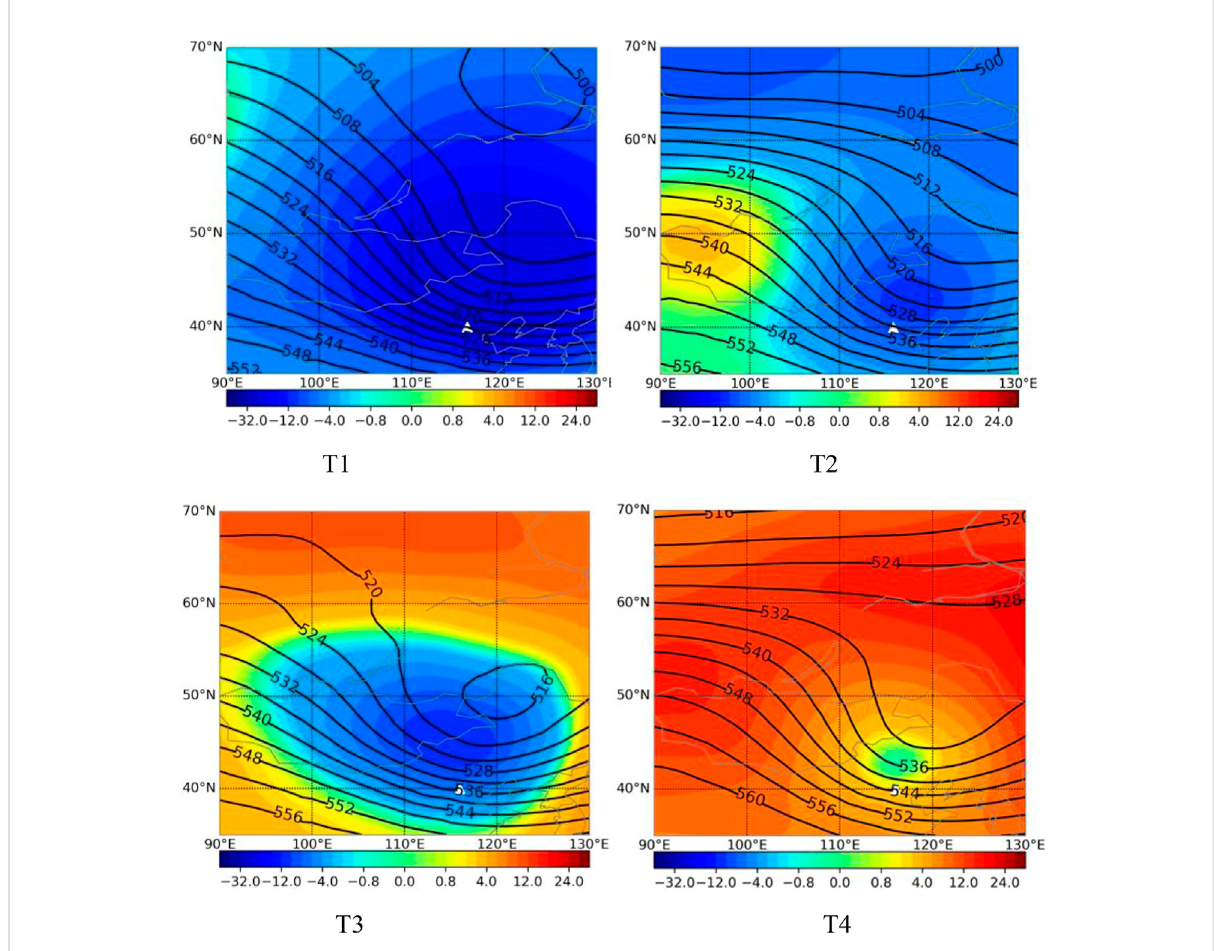
FIGURE 3 The composite fi elds of geopotential height at 500 hPa (contours) for T1, T2, T3 and T4, and their corresponding anomalies to the winter and spring of 1979 – 2019 (shaded). Beijing is marked with the white